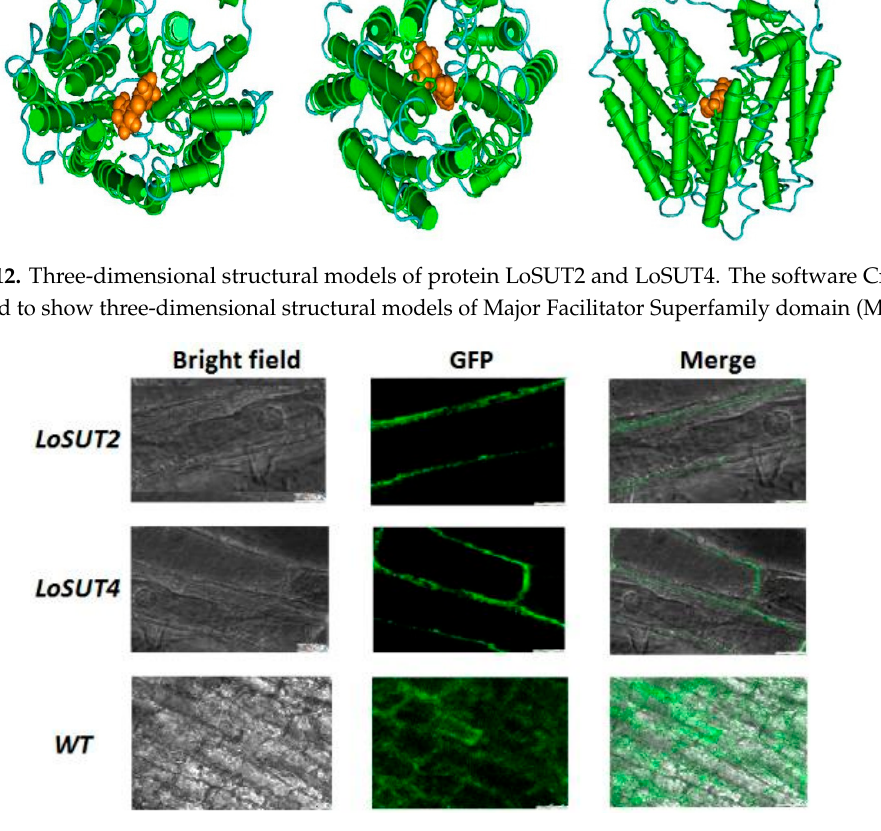
Figure 13. Subcellular localization of LoSUT2 and LoSUT4 in onion epidermis. SUT genes expressed the GFP-highlighted position of proteins.